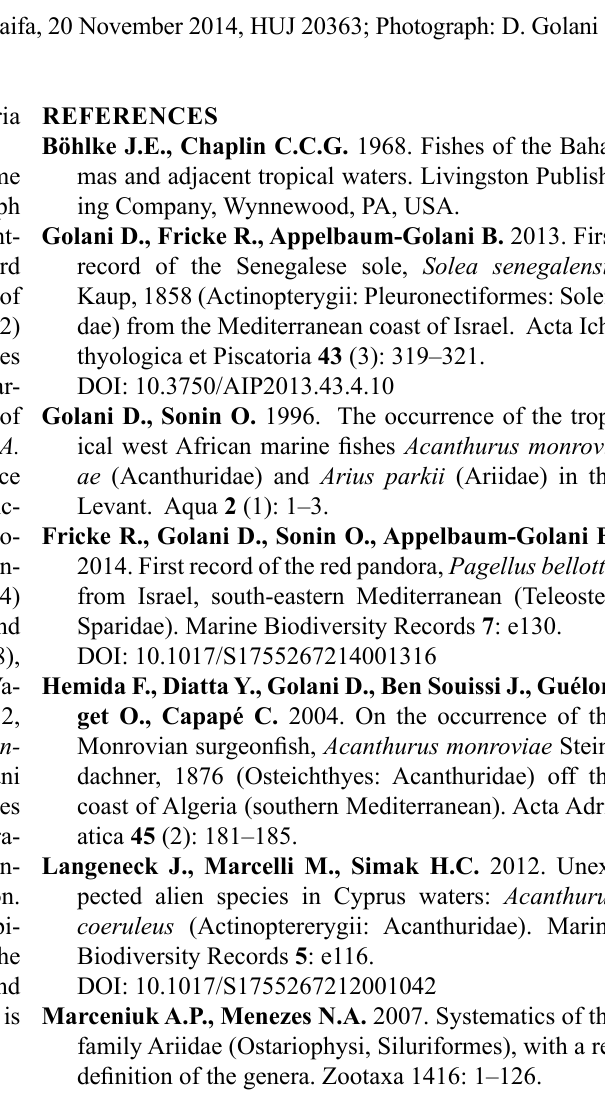
Fig. 1. Blue tang, Acanthurus coeruleus , 120 mm SL, Haifa, 20 November 2014, HUJ 20363; Photograph: D.